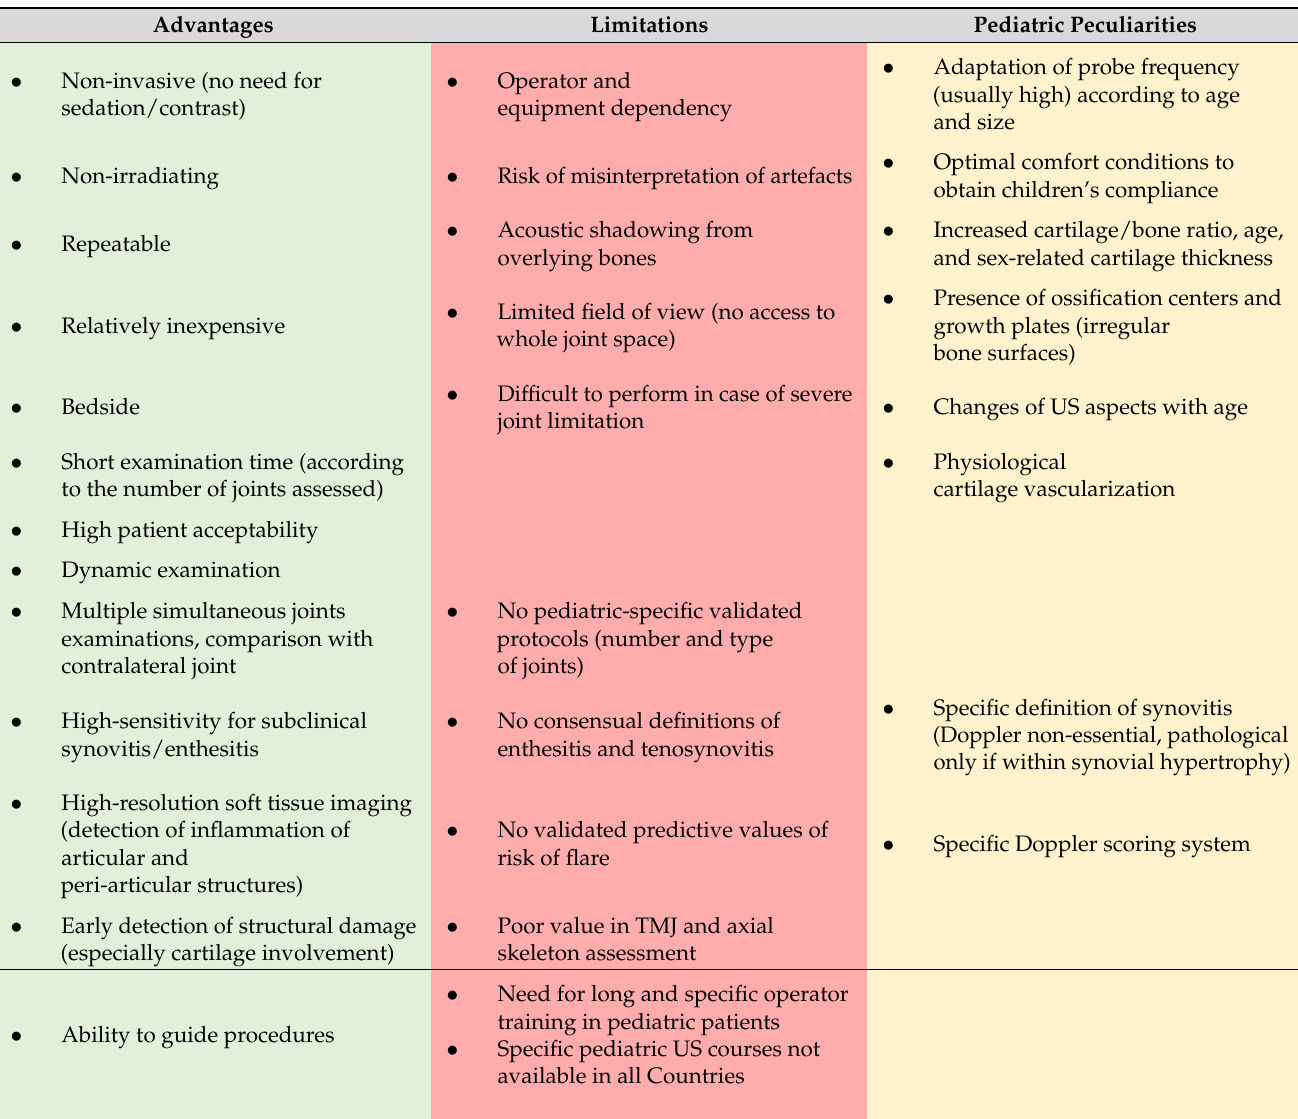
Table 1. Advantages, limitations, and peculiarities of musculoskeletal ultrasound in children with juvenile idiopathic